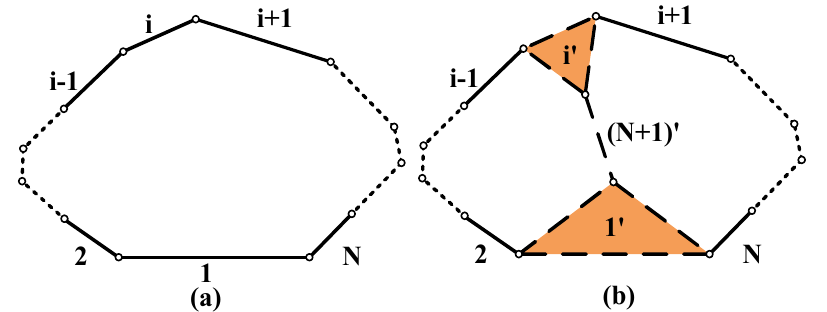
Figure 5. ( a ) Single-loop multi-DOF N-bar (N ≥ 5) planar linkage, ( b ) Two-loop virtual planar linkage with virtual links.